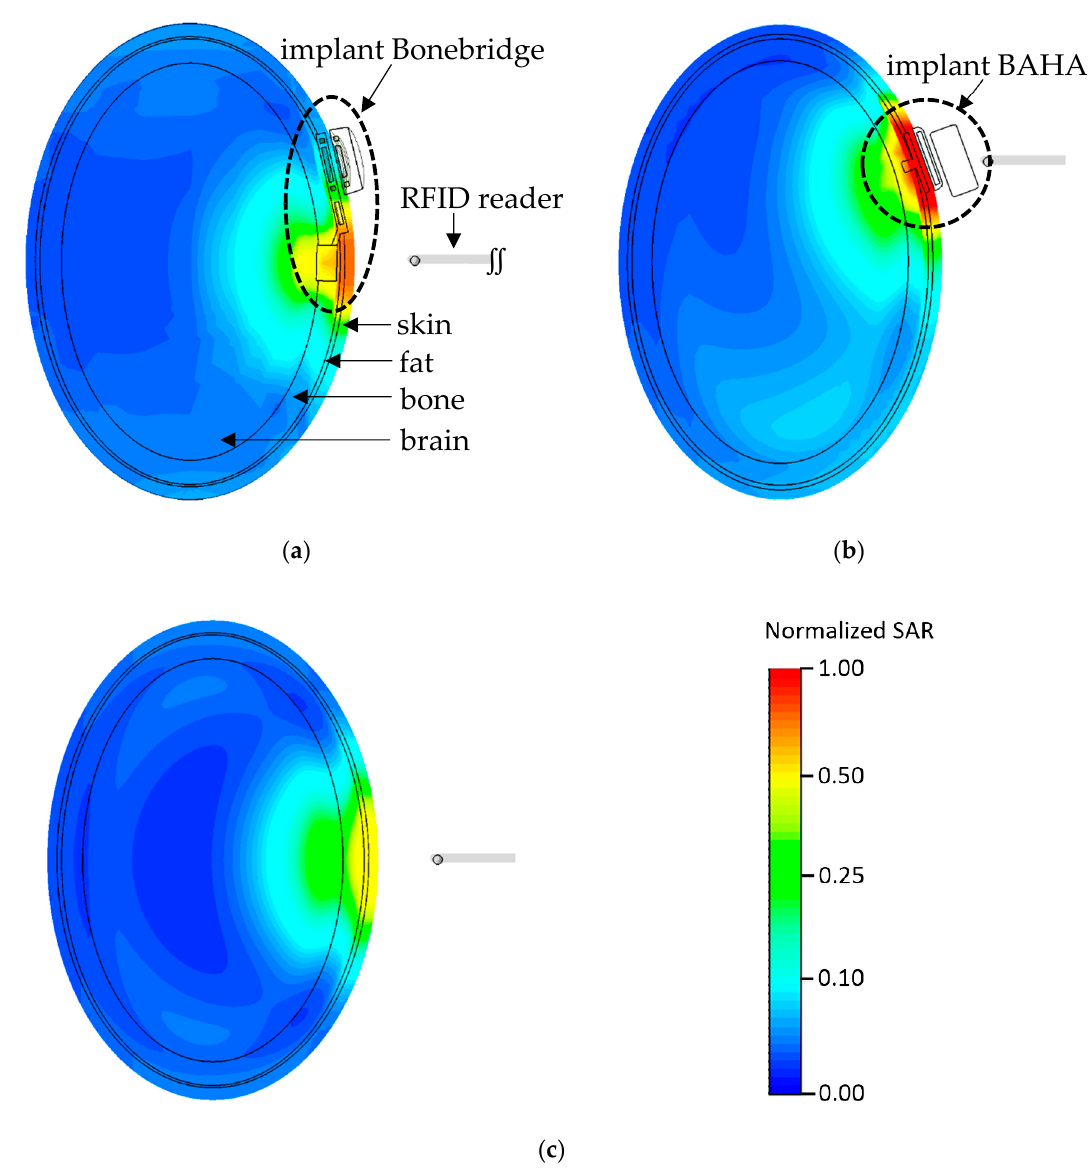
Figure 4. The distribution of localized SAR (at frontal cross-section through the center of the implant part fixed to the bones of the skull) simulated by CST Studio Suite, under exposure to EMF from an RFID HF reader (13.56 MHz) in exposure scenario c, as shown in Figure 2: ( a ) near a Bonebridge implant, ( b ) near a BAHA implant and ( c ) in a non-user (unified normalized logarithmic color scale of absolute SAR values—reference value: maximum localized SAR value calculated for exposure scenario c and BAHA implant user).